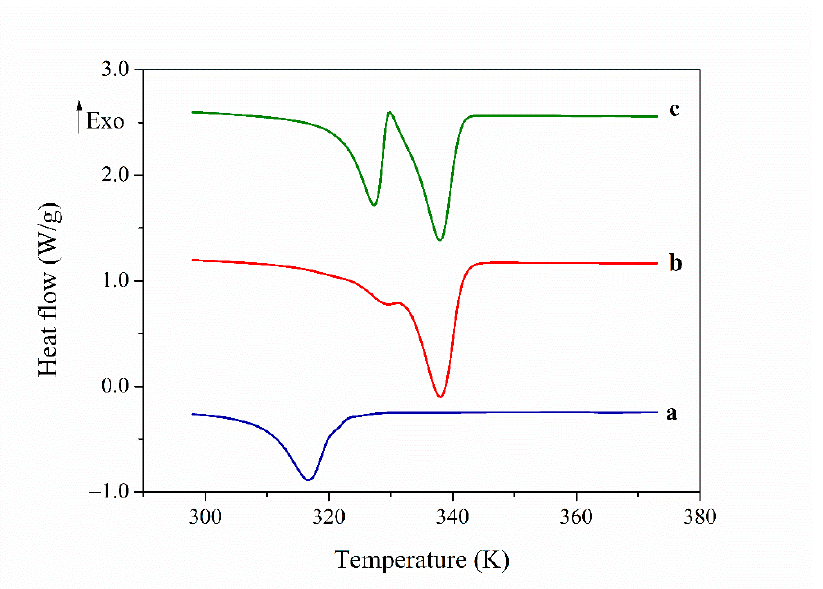
Figure 3. DSC thermogram on second heating of: ( a ) PAZE40; ( b ) PAZE100; ( c ) thermogram of PAZE100 after ( b ) and subsequent annealing 2 h at 318 K.